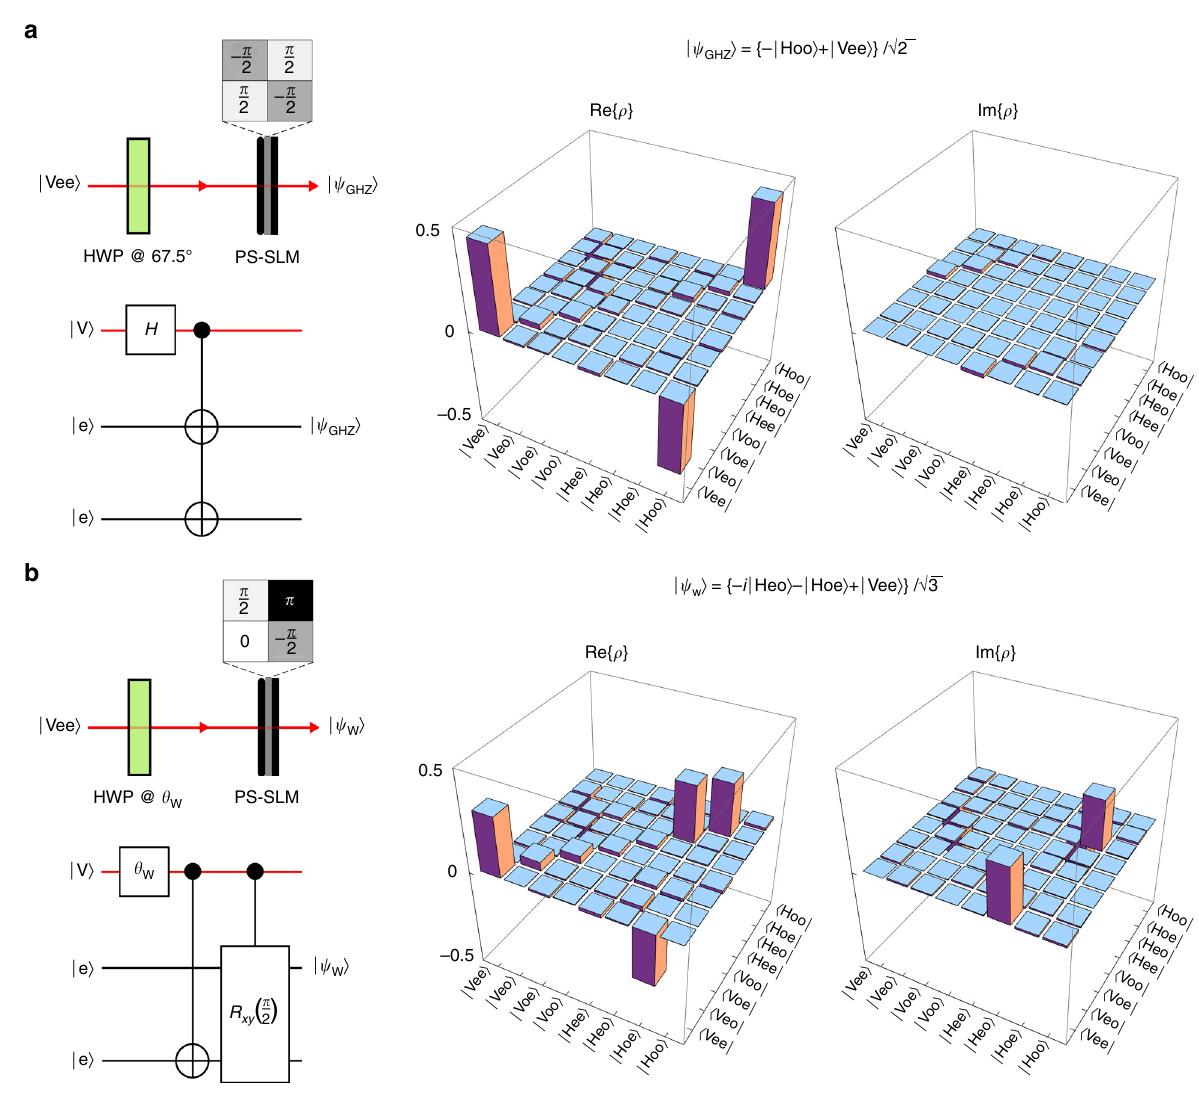
Fig. 7 Producing entangled three-qubit states. a Implementation and quantum circuit for producing a GHZ state from an initially separable generic state. On the right we plot the real and imaginary parts of the three-qubit density operator ρ reconstructed from quantum state tomography measurements. b Same as a to produce a W